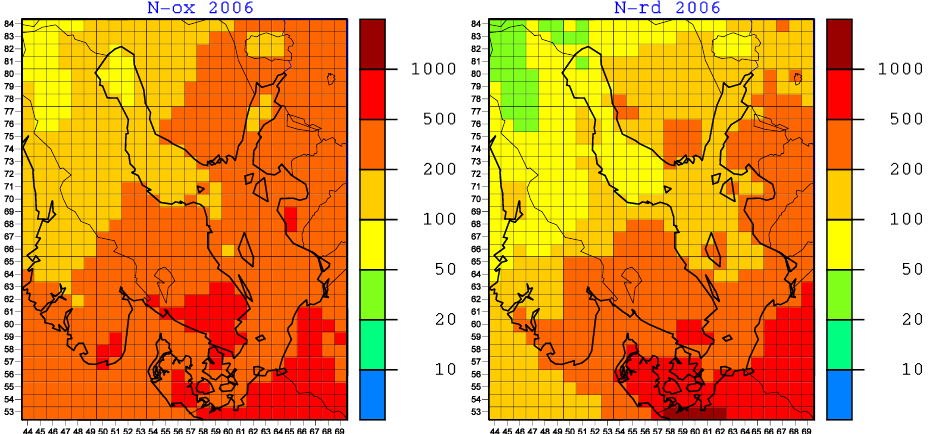
Fig. 6. Map of annual 2006 oxidised nitrogen deposition (left) and annual 2006 reduced nitrogen deposition (right). Units: mgNm − 2